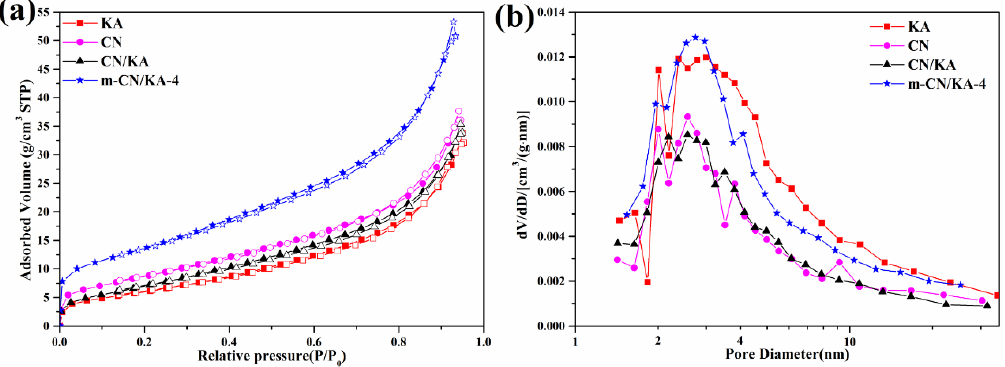
Figure 3. ( a ) N 2 adsorption isotherm and ( b ) pore-size distribution curves of CN, KA, CN/KA composite, and m-CN/KA-4 composite.